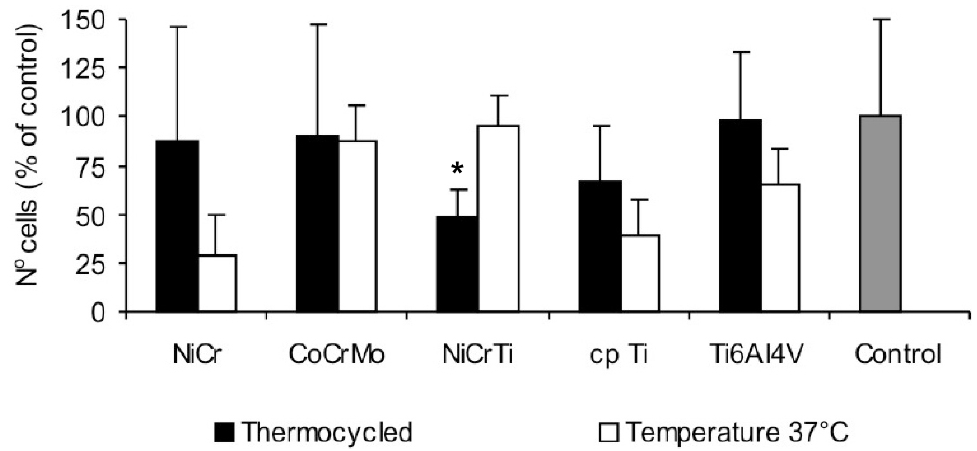
FIGURE 4- Number of cells counted after 6-h contact with alloys and metal extracts, expressed as percentage of control. Data are shown as mean and bar indicates standard deviation (n=4). * statistically different from 37°C